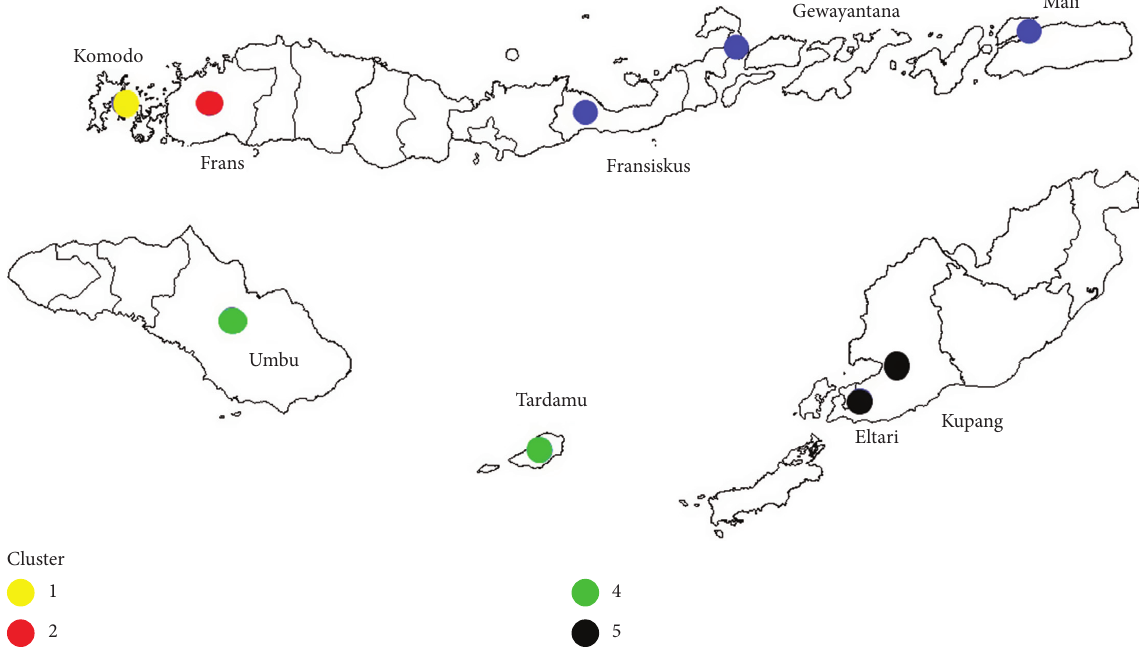
Figure 3: Location of each station based on cluster analysis.